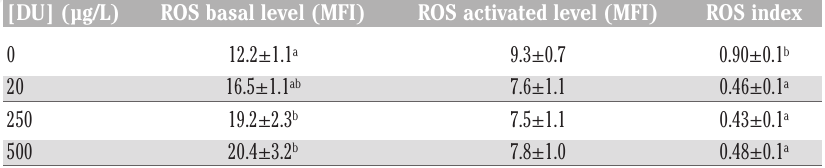
Table 1. Effects of depleted uranium on leucocyte parameters during the ex vivo experi- ment. Values are means of 20 replicates, except for reactive oxygen species values for tech- nical reasons (n comprised between 8 and 14); standard error is presented. [DU] (µg/L)